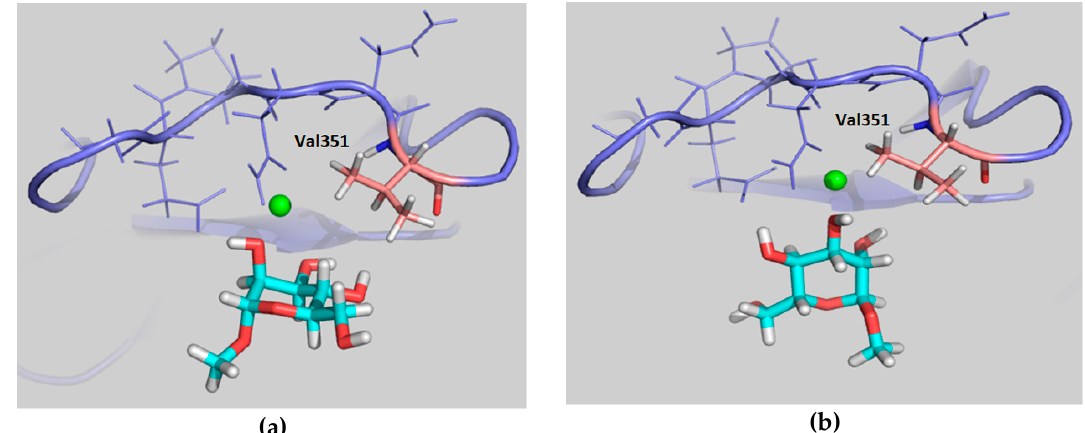
Figure 10. Model frames from the MD simulation performed for α -Me-Man bound to DC-SIGN in poses A ( a ) and B ( b ). For pose A, H-4 and H-6 are close to Val351, whereas H-2 and H-3 points towards the polar region defined by Asn349, Asn365, and Glu354. In contrast, for pose B, the alternative situation takes place, with H-2 and H-3 pointing towards Val351.